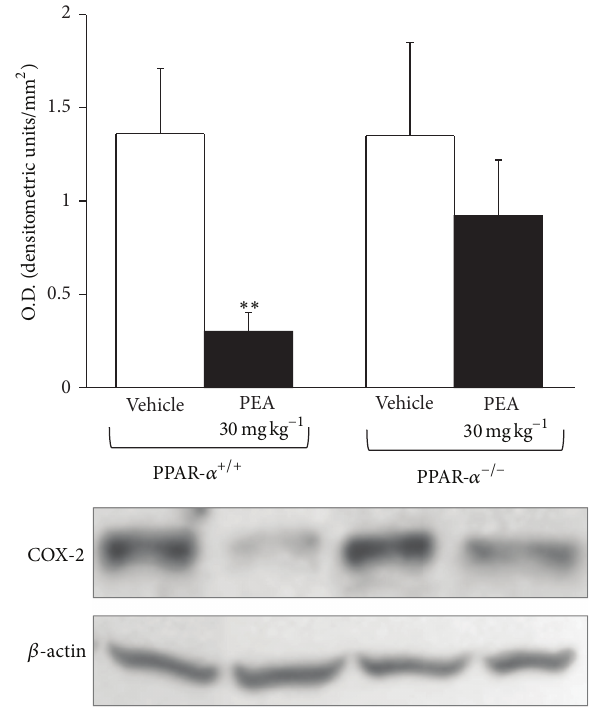
Figure 10: COX-2 expression levels in spinal cord. On the 14th day the spinal cord of PPAR- 𝛼 +/+ and PPAR- 𝛼 −/− mice was analyzed by western blot. Upper panel shows the densitometric quantification of COX-2 levels in CCI vehicle-treated animal in comparison with CCI mice repetitively treated with PEA (30mgkg −1 s.c. daily). Values were normalized to 𝛽 -actin immunoreactivity. Data are expressed as the mean ± SEM of triplicate determinations performed on 5 animals for each group. ∗∗ 𝑃 < 0.01 was considered as significantly different from vehicle